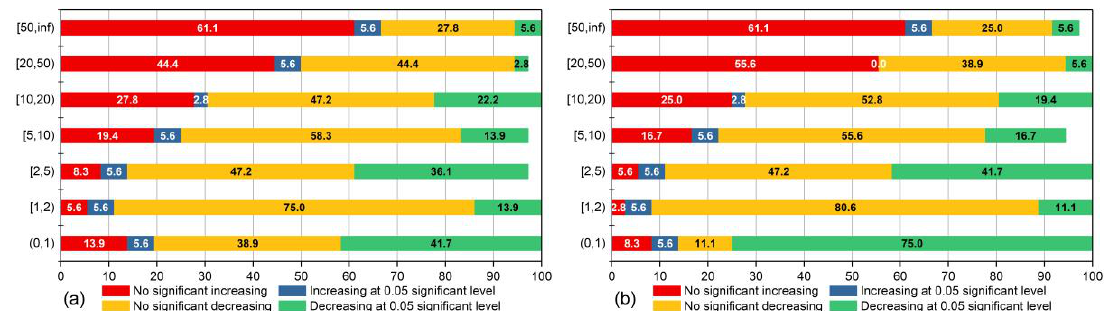
Figure 7. Results of the Mann – Kendall trend test of daily precipitation classification for 36 meteorological stations. ( a ) The annual precipitation falling within each classification interval. ( b ) The total numbers of daily precipitation events falling within each classification interval every year. The X axis represents that percentages of meteorological stations with the same trend of change (increasing or decreasing, significant increasing or decreasing at a 0.05 level).